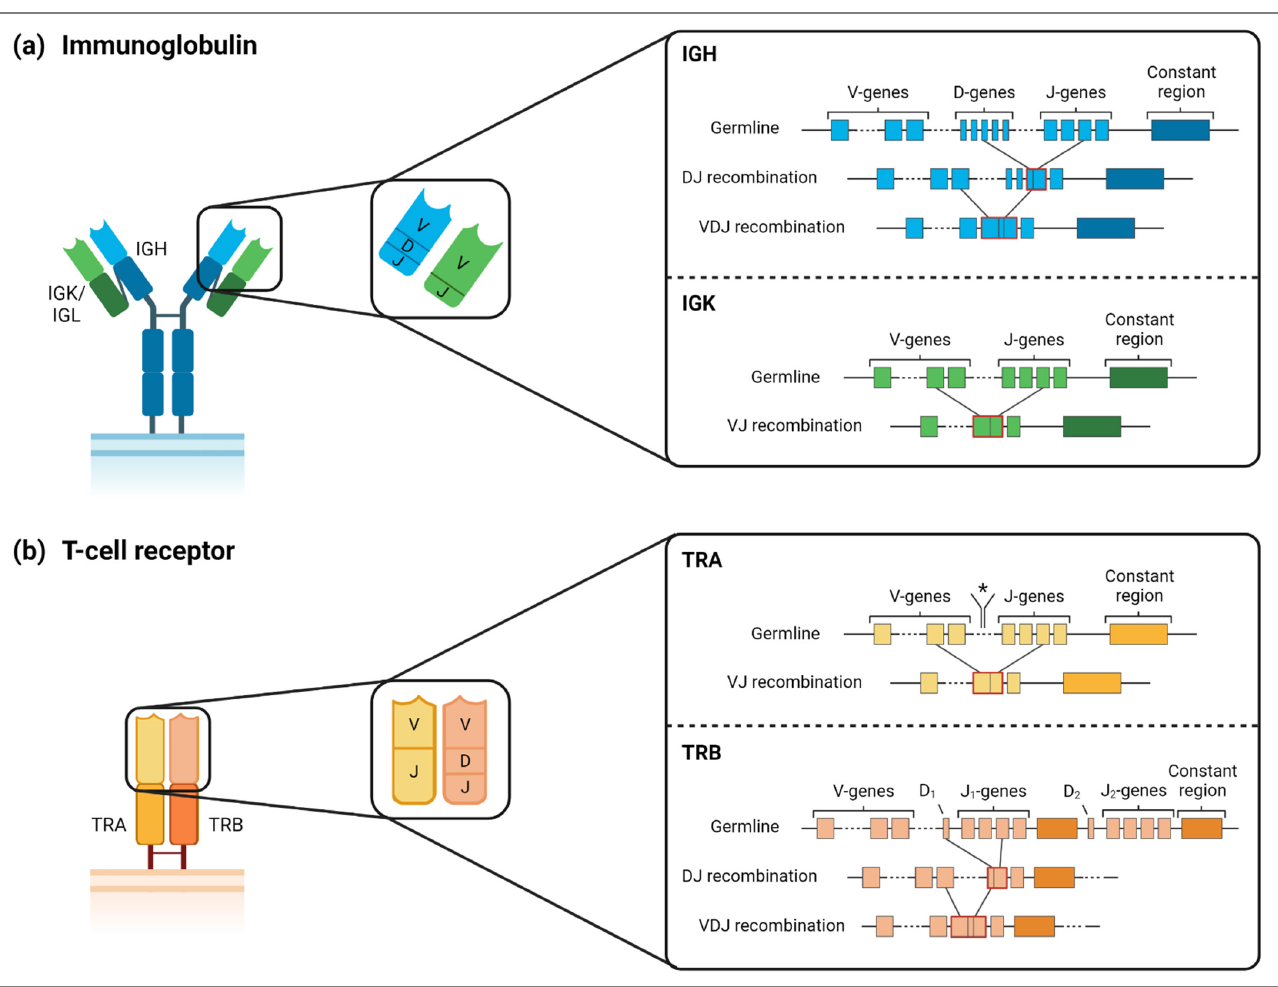
Figure 1. Schematic overview of immunoglobulin and T-cell receptor V(D)J gene rearrangements. ( a ) Immunoglobulin (IG) gene rearrangements generate a B-cell receptor, where IG heavy chain (IGH) genes are represented in blue, while IG kappa (IGK) and IG lambda (IGL) light chain genes are indicated in green. In this figure, only (potentially) productive IGH and IGK gene rearrangements are shown. In case of a non-productive IGK rearrangement, the kappa deleting element will rearrange with an upstream IGK-V gene or the Intron-RSS sequence (not shown in this figure). If both alleles result in a non-productive IGK light chain, the IGL light chain will rearrange, according to a similar process as IGK (not shown in this figure). Please note that the structure of the IGL chain is slightly different compared to the IGK chain shown here, since each IGL constant region is preceded by a single IGL-J gene. ( b ) V(D)J gene rearrangements of alpha/beta T-cell receptor. TR alpha (TRA) chain is represented in yellow, TR beta (TRB) chain in orange. Gamma/delta T-cell receptors are generated similarly, where TR gamma (TRG) chain undergoes VJ rearrangement similar to TRA, while TR delta (TRD) chain is generated by VDJ rearrangement, like TRB. Please note that the TRD gene cluster is located between the TRA-V and TRA-J gene clusters, as indicated with an asterisk. This TRD gene cluster will be deleted upon TRA gene rearrangements. For both IG and TCR, dark shades represent the constant regions, while the lighter shades correspond to variable regions, which are composed of rearranged V, (D) and J